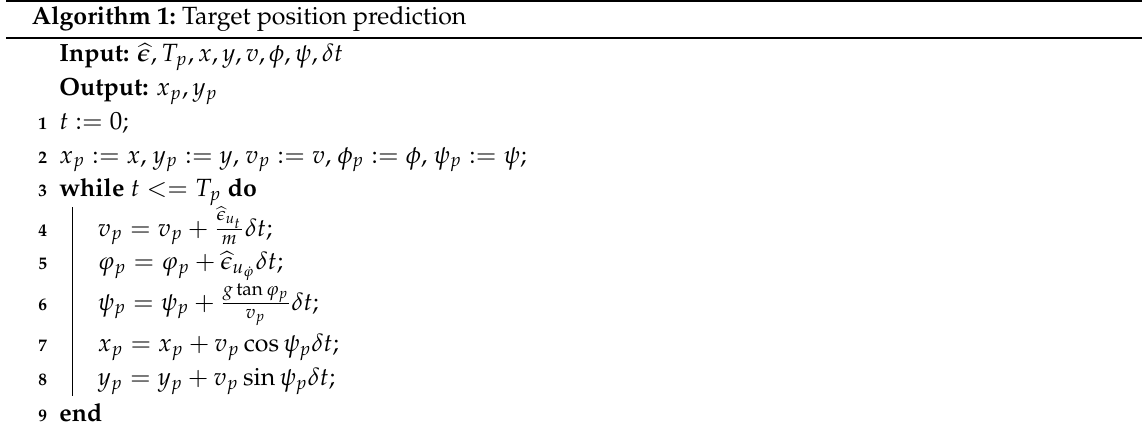
Algorithm 1: Target position